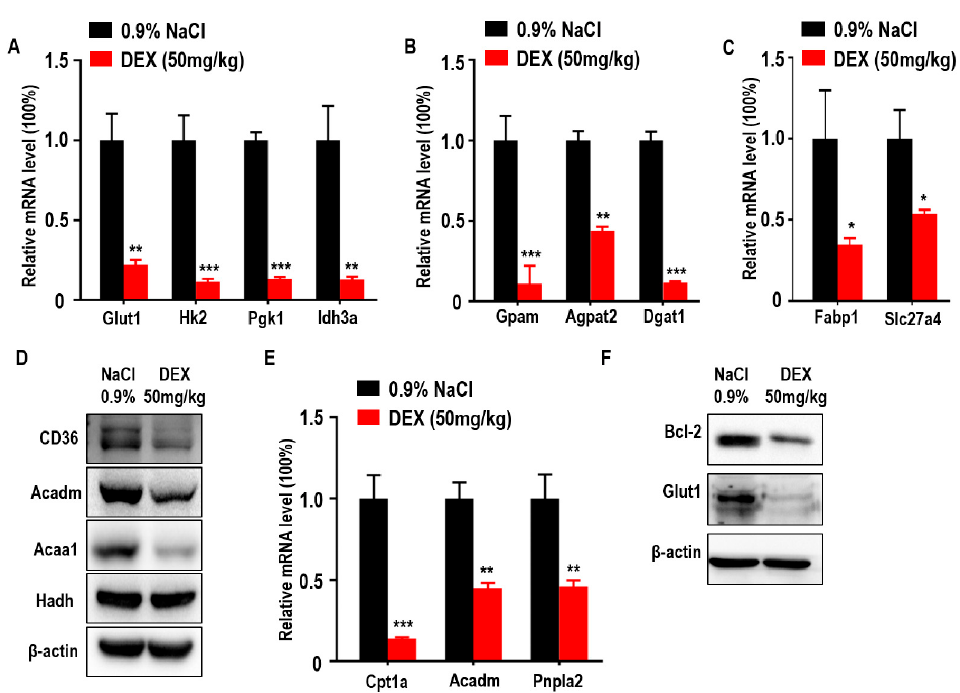
Figure 3. High-dose DEX injection inhibited the expression of enzymes relevant to glycolysis, triglyceride (TG) synthesis, free fatty acid (FFA) import, and fatty acid oxidation (FAO). ( A ) Quantitative RT-PCR analysis of genes relevant to glucose transporter and glycolysis enzymes in tumors from mice after treatment with 0.9% NaCl or DEX. ( B ) Quantitative RT-PCR analysis of glycerol-3-phosphate acyltransferase ( Gpam ), 1-acylglycerol-3-phosphate O-acyltransferase ( Agpat2 ), and diacylglycerol O-acyltransferase 1 ( Dgat1 ) in tumors from mice after treatment with 0.9% NaCl or DEX. ( C ) Quantitative RT-PCR analysis of fatty acid binding protein 1 ( Fabp1 ) and solute carrier family 27 member 4 ( Slc27a4 ) in tumors from mice after treatment with 0.9% NaCl or DEX. ( D ) Immunoblot analysis of CD36 and FAO pathway enzymes in tumors treated with 0.9% NaCl or DEX (50 mg / kg), respectively. ( E ) Quantitative RT-PCR analysis of genes relevant to FAO pathway enzymes in tumors from mice after treatment with 0.9% NaCl or DEX. ( F ) Immunoblot analysis of Bcl-2 and glucose transporter 1 (Glut1) in tumors treatment with 0.9% NaCl or DEX (50 mg / kg), respectively. Results representative of three independent experiments. All data are presented as mean ± SEM and p < 0.05 is considered significant (* p < 0.05, ** p < 0.01, *** p < 0.001; n = 3 mice per